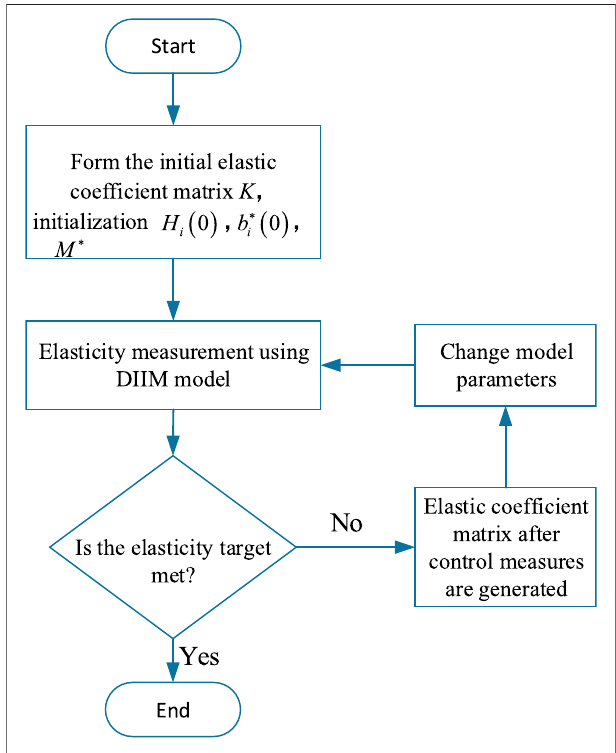
FIGURE 3 | Flow chart of the DIIM power grid resilience measurement.